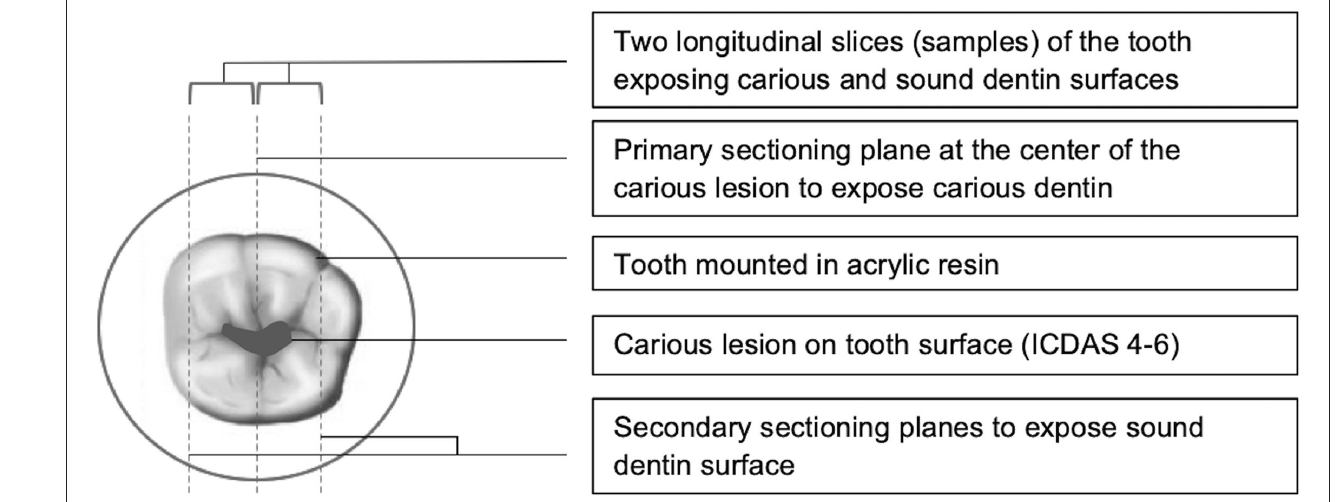
FIGURE 1 | Sectioning planes for sample